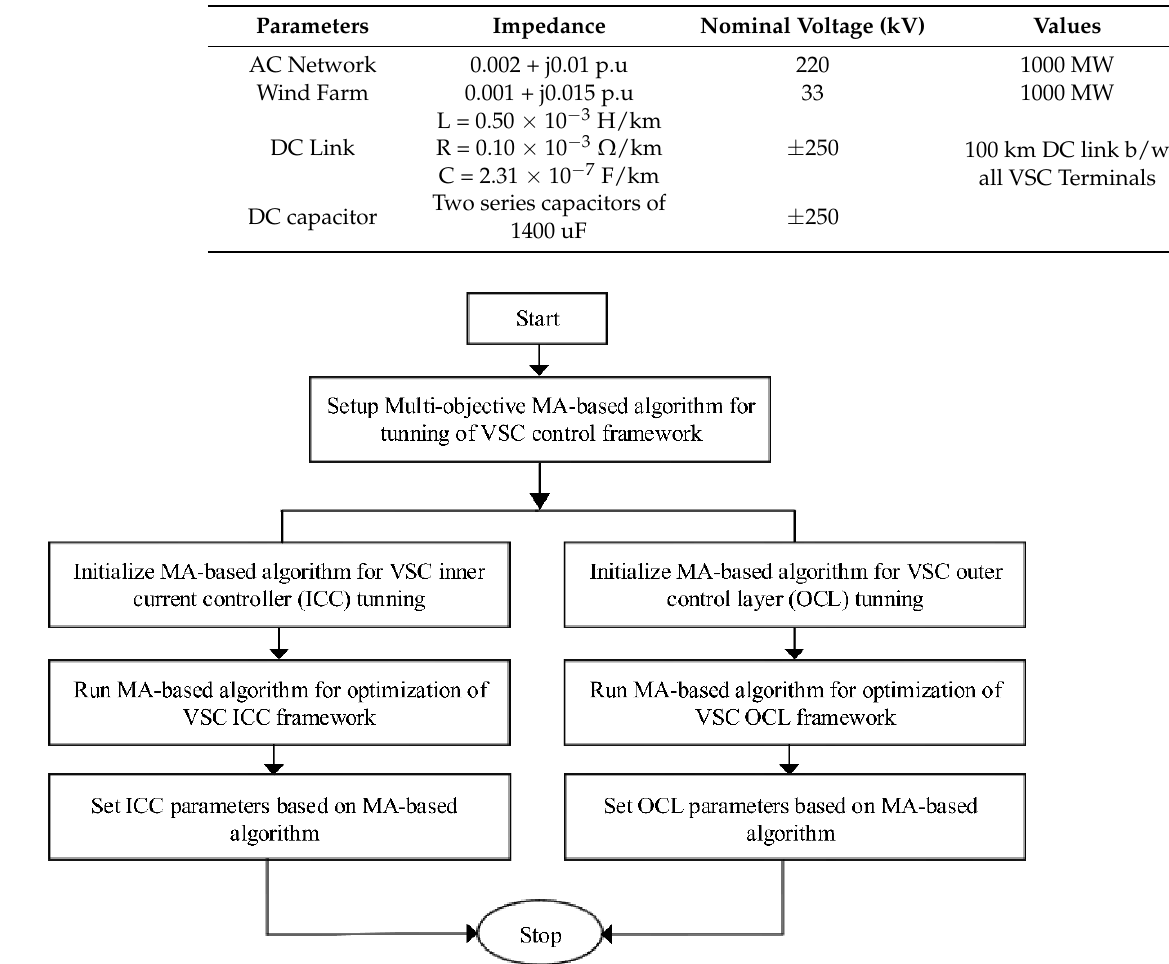
Figure 2. Optimization of the VSC-based control framework using the proposed algorithm.